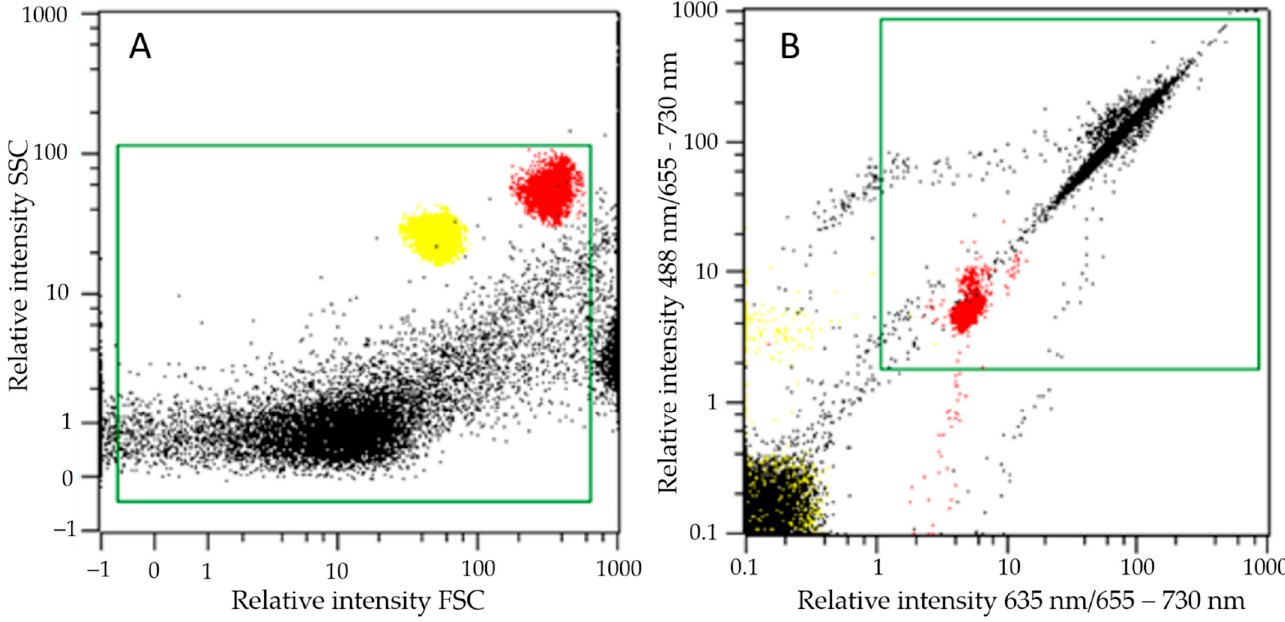
Figure 8. Flow cytometer plots of ( A ) NFP, attributed mainly to bacteria and SCPs; ( B ) AFP, attributed to microalgal cells. Clusters of fluorescent calibration beads are overlaid for comparison: 2 µ m beads (left, yellow) and 3 µ m beads (right, red). Yellow beads in B are clustered in the bottom left, with a negligible amount above that. Gates for selecting points for quantification of NFPs and AFPs (green squares) are also shown.